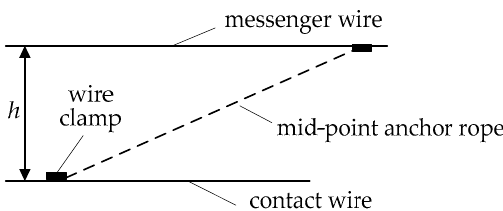
Figure 7. Schematic diagram of mid-point anchor rope installation.